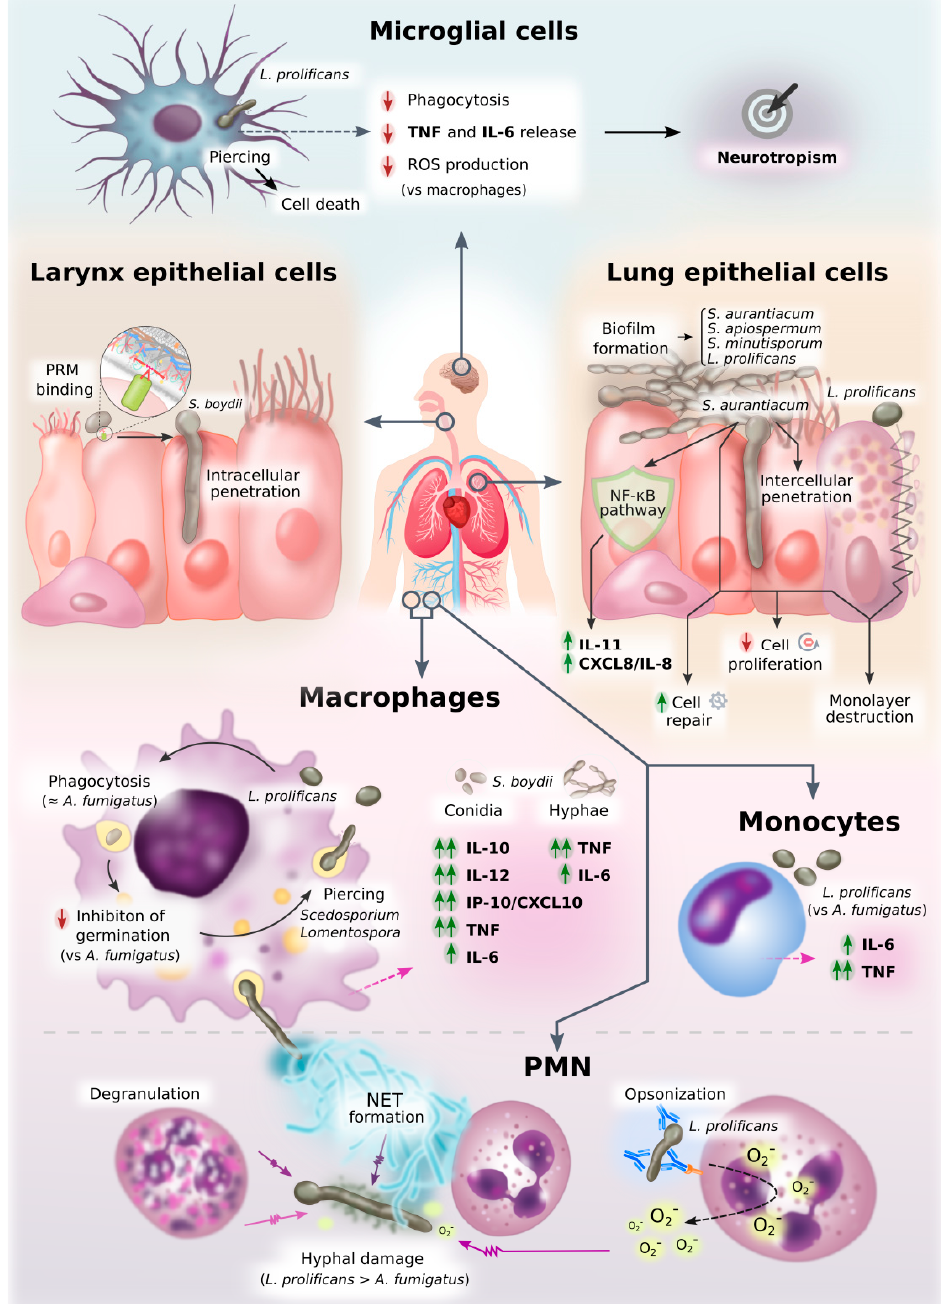
Figure 3. Diagram of innate immune response against Scedosporium / Lomentospora . This figure graphically represents an overview of all the information on innate cell interactions with Scedosporium/Lomentospora gathered in this